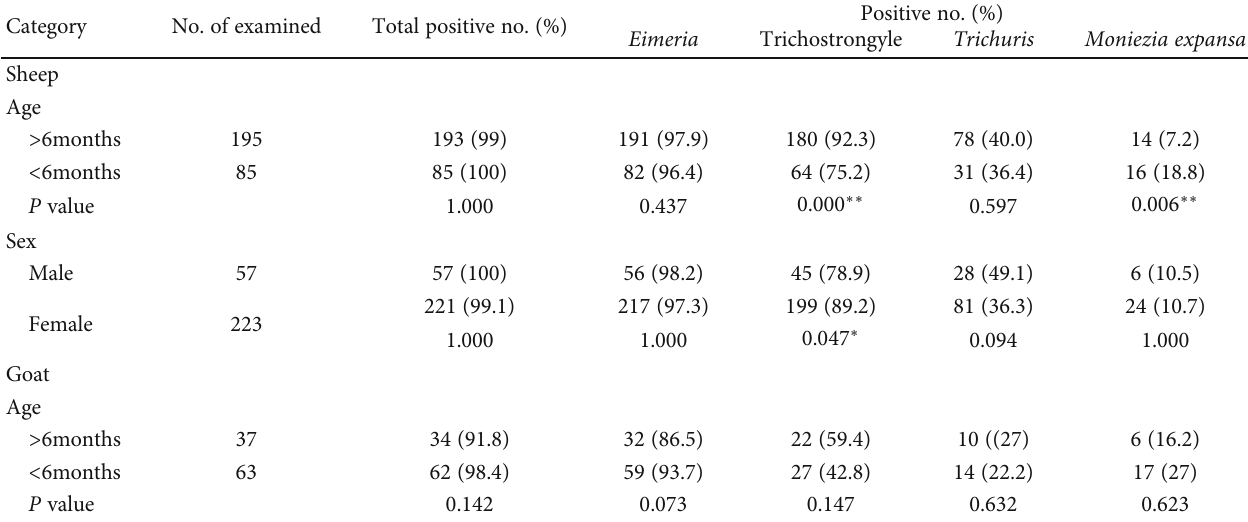
Table 5: Description of gastrointestinal parasites according to age and sex of sheep and